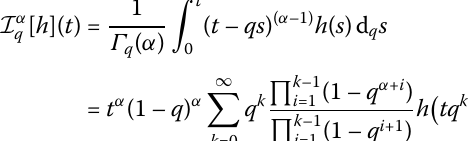
Table 2 Some numerical results for calculation of Γ q ( x ) with q = 1 Algorithm